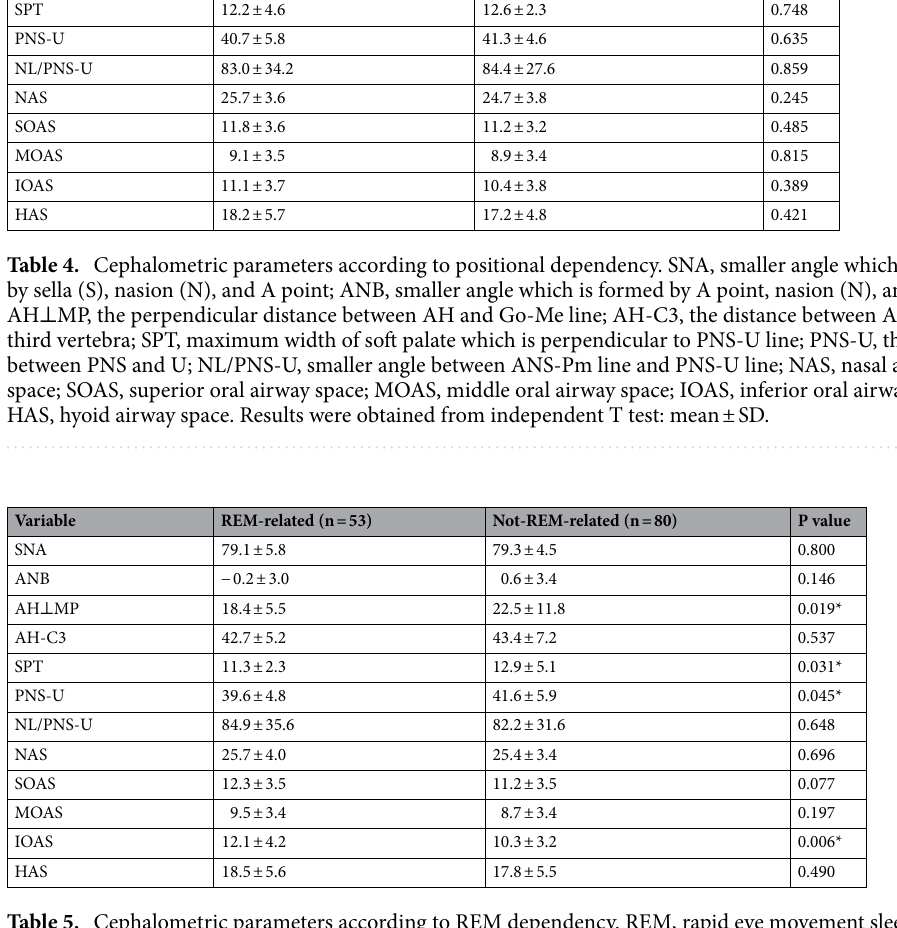
Table 5. Cephalometric parameters according to REM dependency. REM, rapid eye movement sleep; SNA, smaller angle which is formed by sella (S), nasion (N), and A point; ANB, smaller angle which is formed by A point, nasion (N), and B point; AH ⊥ MP, the perpendicular distance between AH and Go-Me line; AH-C3, the distance between AH and the third vertebra; SPT, maximum width of soft palate which is perpendicular to PNS-U line; PNS-U, the distance between PNS and U; NL/PNS-U, smaller angle between ANS-Pm line and PNS-U line; NAS, nasal airway space; SOAS, superior oral airway space; MOAS, middle oral airway space; IOAS, inferior oral airway space; HAS, hyoid airway space. Results were obtained from independent T-test: mean ± SD. *Significant difference: p <